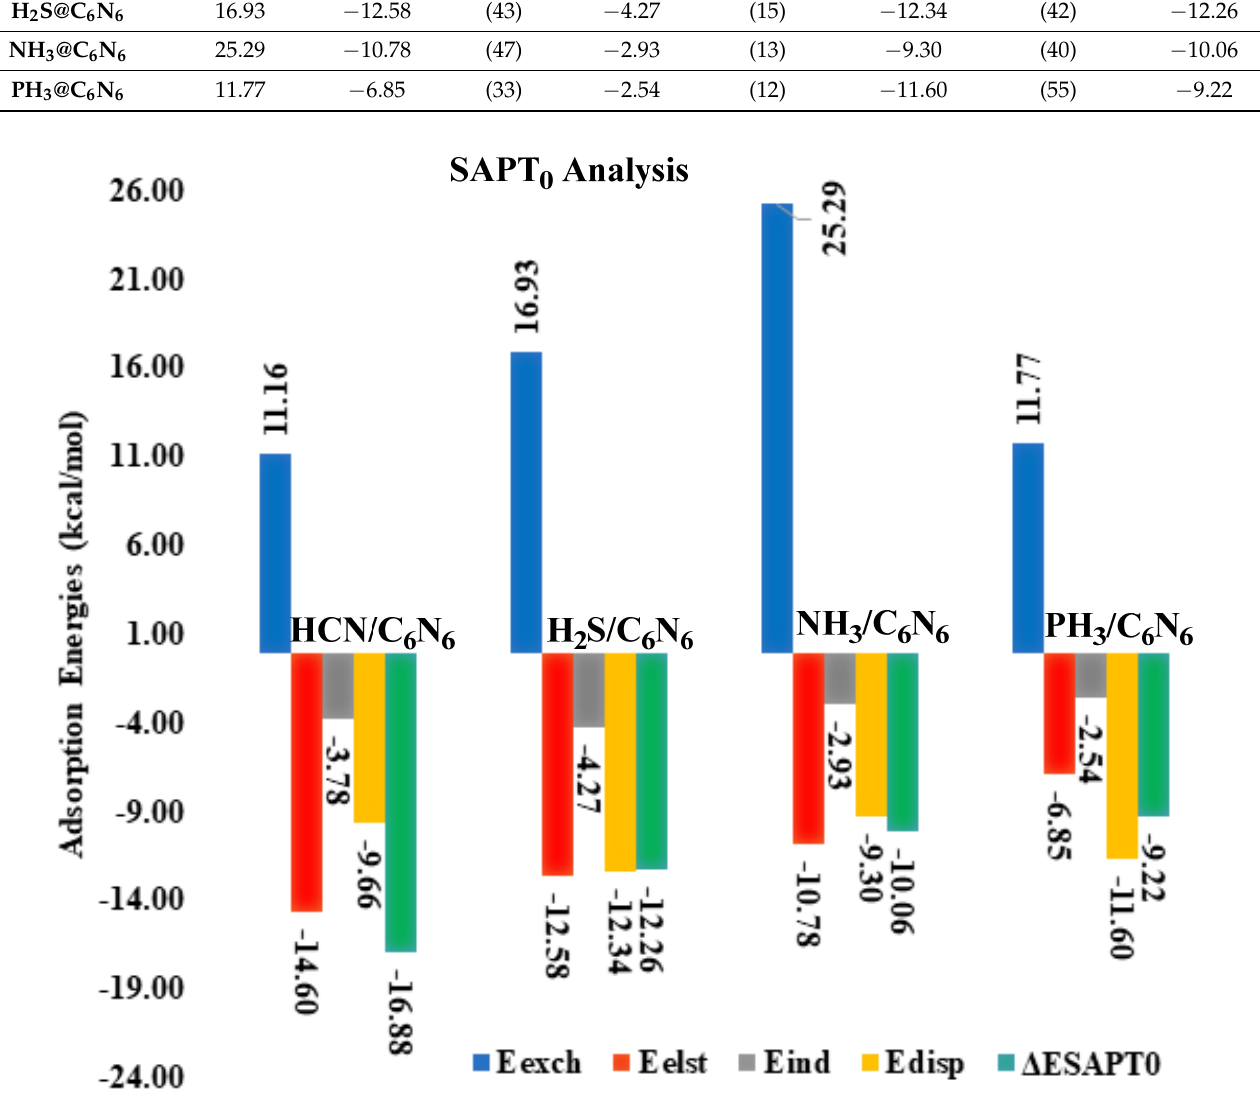
Figure 3. Graphical projection of the SAPT0 energy and its components for analyte@C 6 N 6 com- plexes.